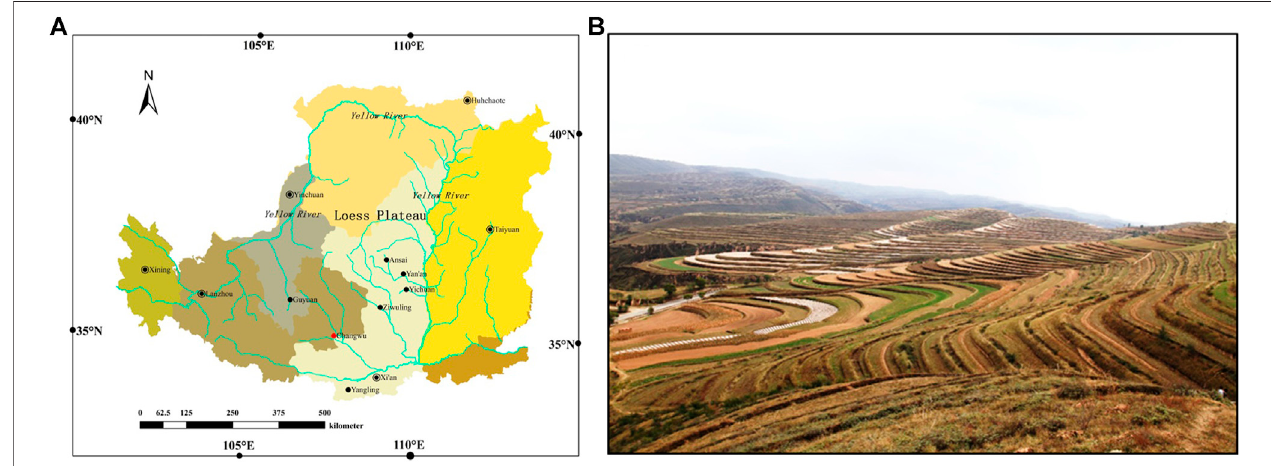
FIGURE 1 | Geolocation of the Chinese Loess Plateau (A) (Wang et al., 2017a) and terraced cropland commonly seen there (B) (photo taken by SG).